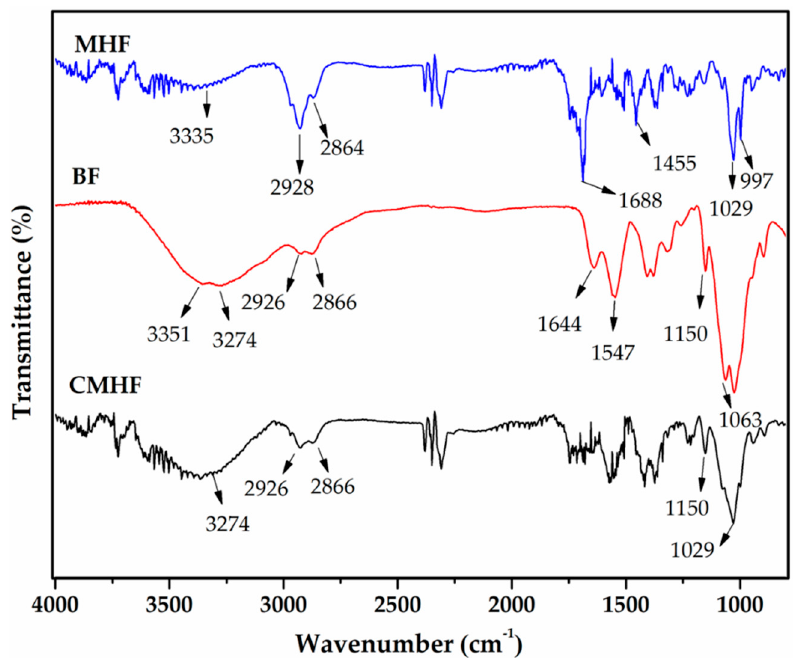
Figure 2. Fourier transform infrared spectroscopy (FTIR) analyses of MHF, blank chitosan film (BF), and chitosan films containing MHF (CMHF).